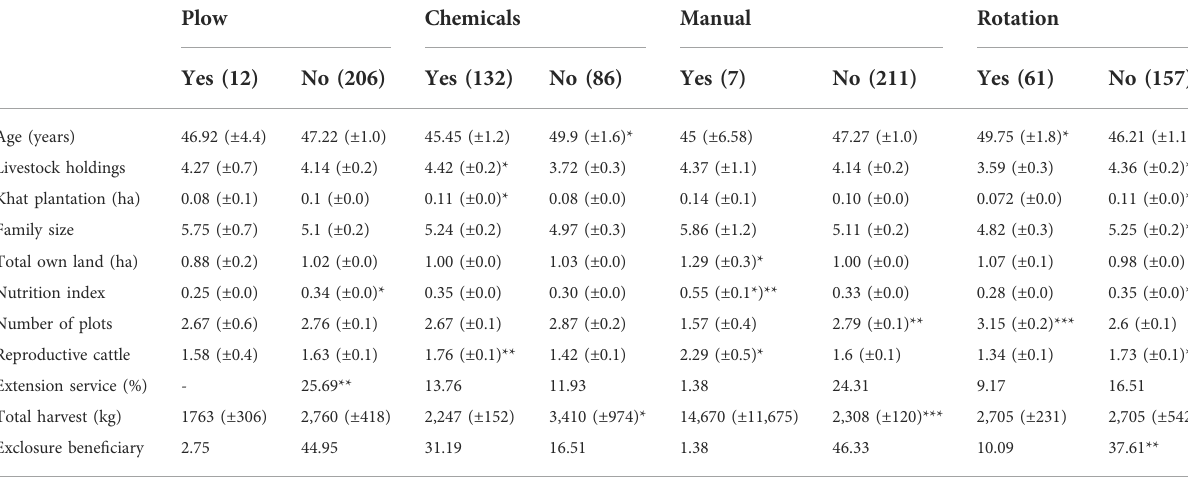
TABLE 4 Typologies of households using different weed and pest control